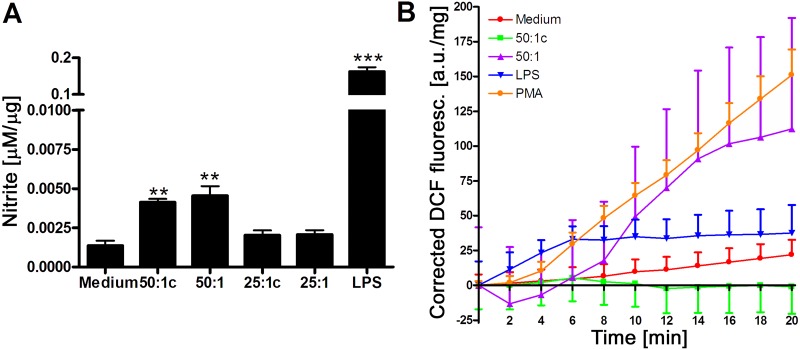
A: Nitrite production after 24-h incubation of RAW 264.7 cells with AML12 hepatocyte-derived DAMPs. Data are plotted as mean ± SEM with N = 7-8 per group. B: Real-time ROS production after 24-h incubation of RAW 264.7 cells with AML12-derived DAMPs. Data are plotted as mean ± SEM with N = 4 per group. * indicates p < 0.05, ** indicates p < 0.01, and *** indicates p < 0.001 compared to the medium group. Abbreviations: c, centrifuged; LPS, lipopolysaccharide; PMA, phorbol 12-myristate 13-acetate; DCF, dichlorofluorescein.